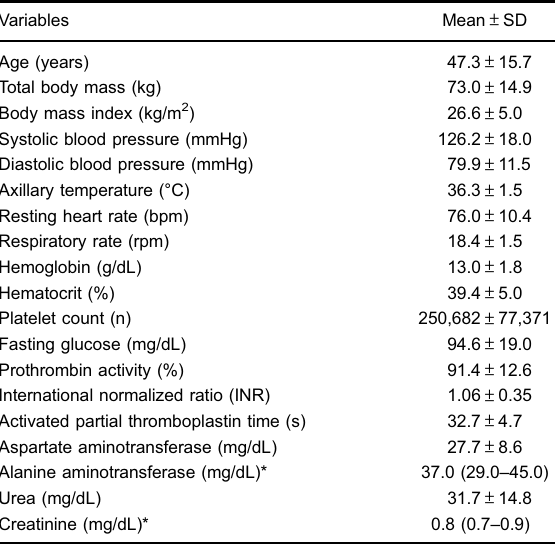
Table 1. Characterization of patients included in the study from Salvador, BA, Brazil (n=778). Variables